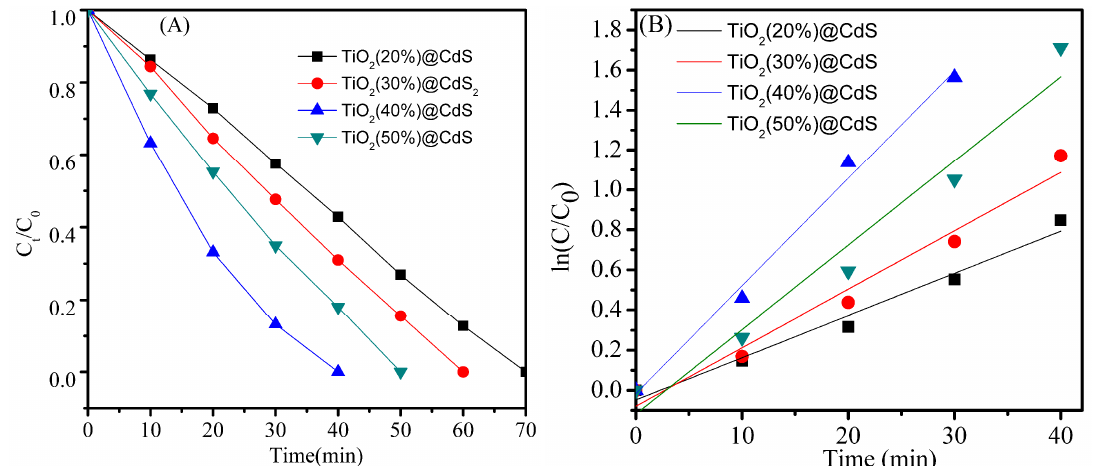
Figure 8. ( A ) Photocatalytic degradation of methyl orange of TiO 2 nanorod–CdS nanoparticle composites; ( B ) first order kinetic equation of TiO 2 nanorod–CdS nanoparticle composites.